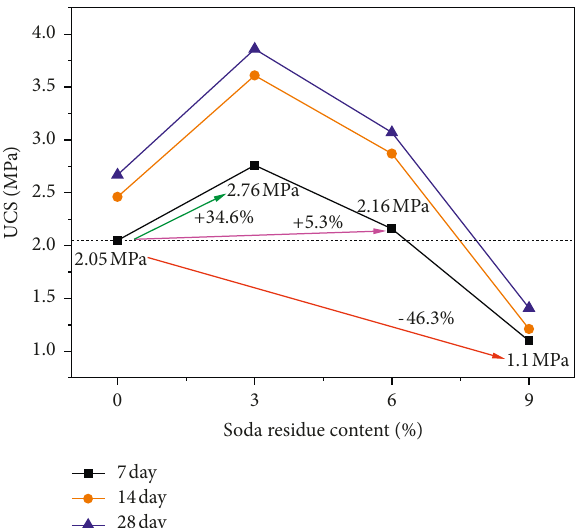
Figure 8: SR content-UCS curve.